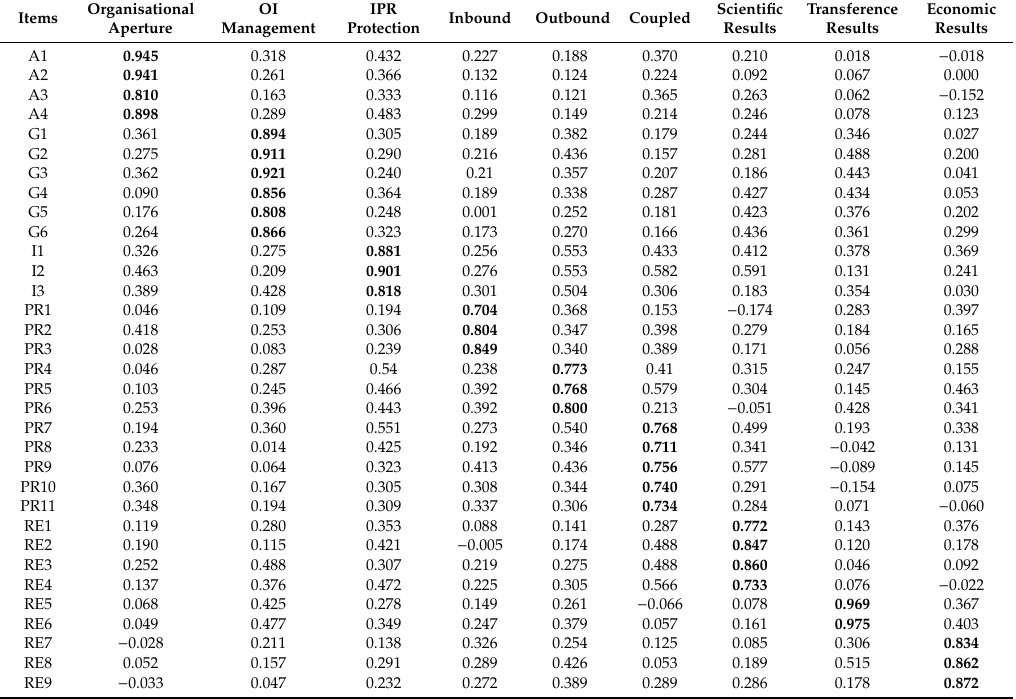
Table 7. Items cross